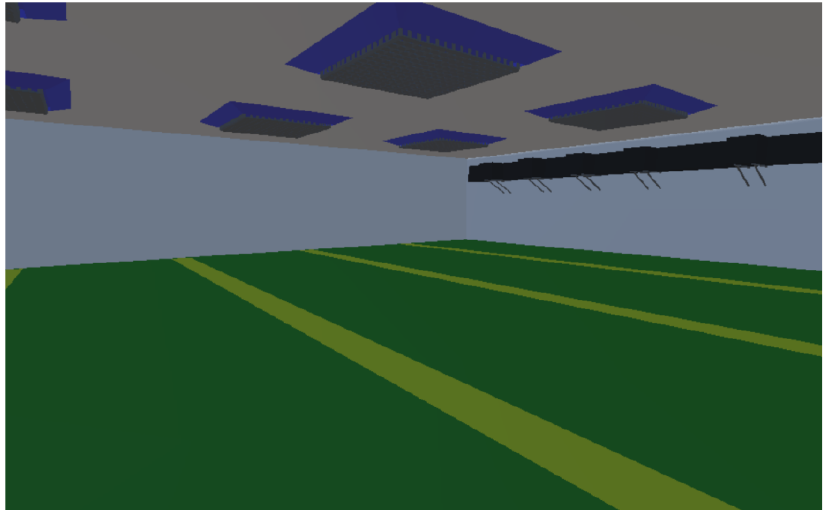
Figure 5. Integrated circuit clean room.